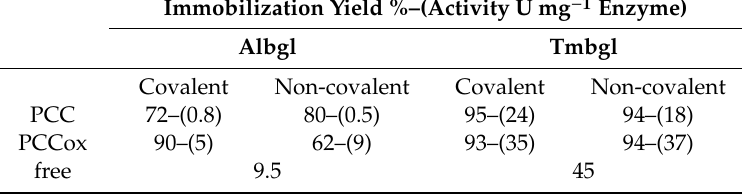
Table 1. The immobilization yield (%) and enzymatic activity of β -glucosidase on PCC and PCCox after covalent and non-covalent immobilization (the standard deviation was less than 5% in all